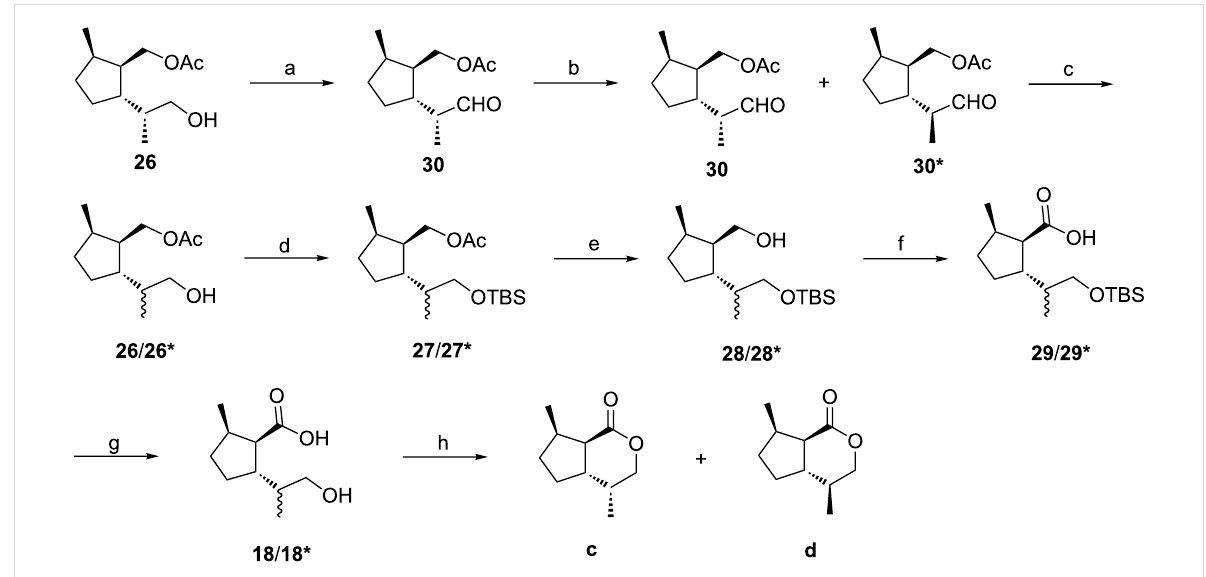
Scheme 5: Synthesis of a 2:3 mixture of dihydronepetalactones c and d . Reaction conditions: a) (COCl) 2 , DMSO, CH 2 Cl 2 , − 70 °C to 0 °C (71%); b) p -TsOH, benzene, reflux (96%); c) NaBH 4 , MeOH, − 20 °C; d) TBDMSCl, imidazole, DMF, 0 °C (78%) (over two steps); e) KOH, MeOH, rt